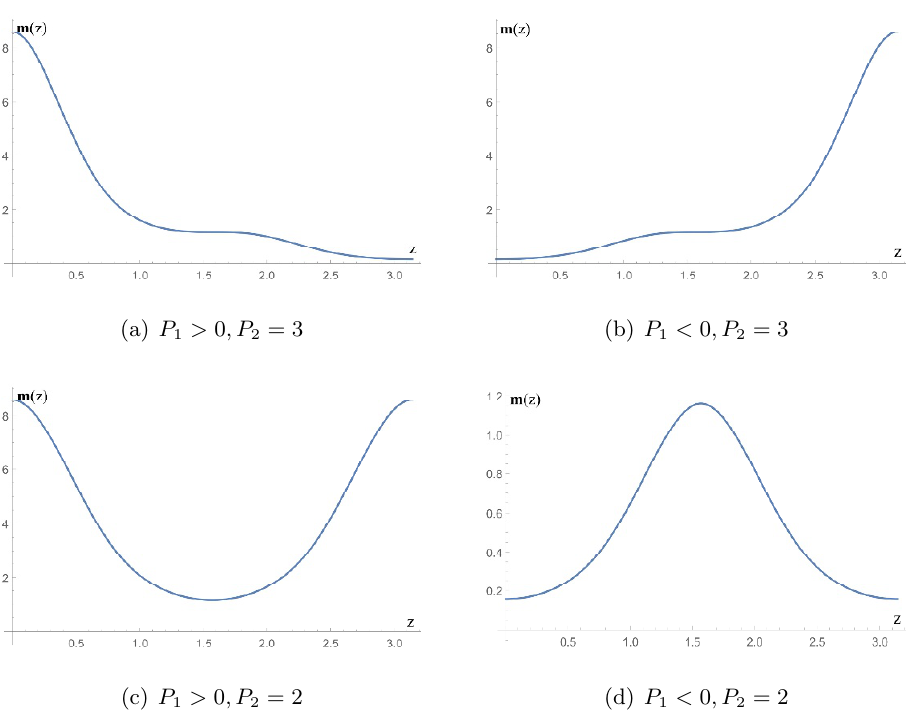
Figure 1 . Branches of lumpy black holes. The horizontal axis is z and the vertical axis is the mass density m ( z ). In these panels, we take Q 2 = 4 = 25, P 1 = (cid:6) 2 and P 2 = 2 or 3 for illustration. Note that the measures on the vertical axes in the (cid:12)gures are not uniformized in order to show the symmetry more